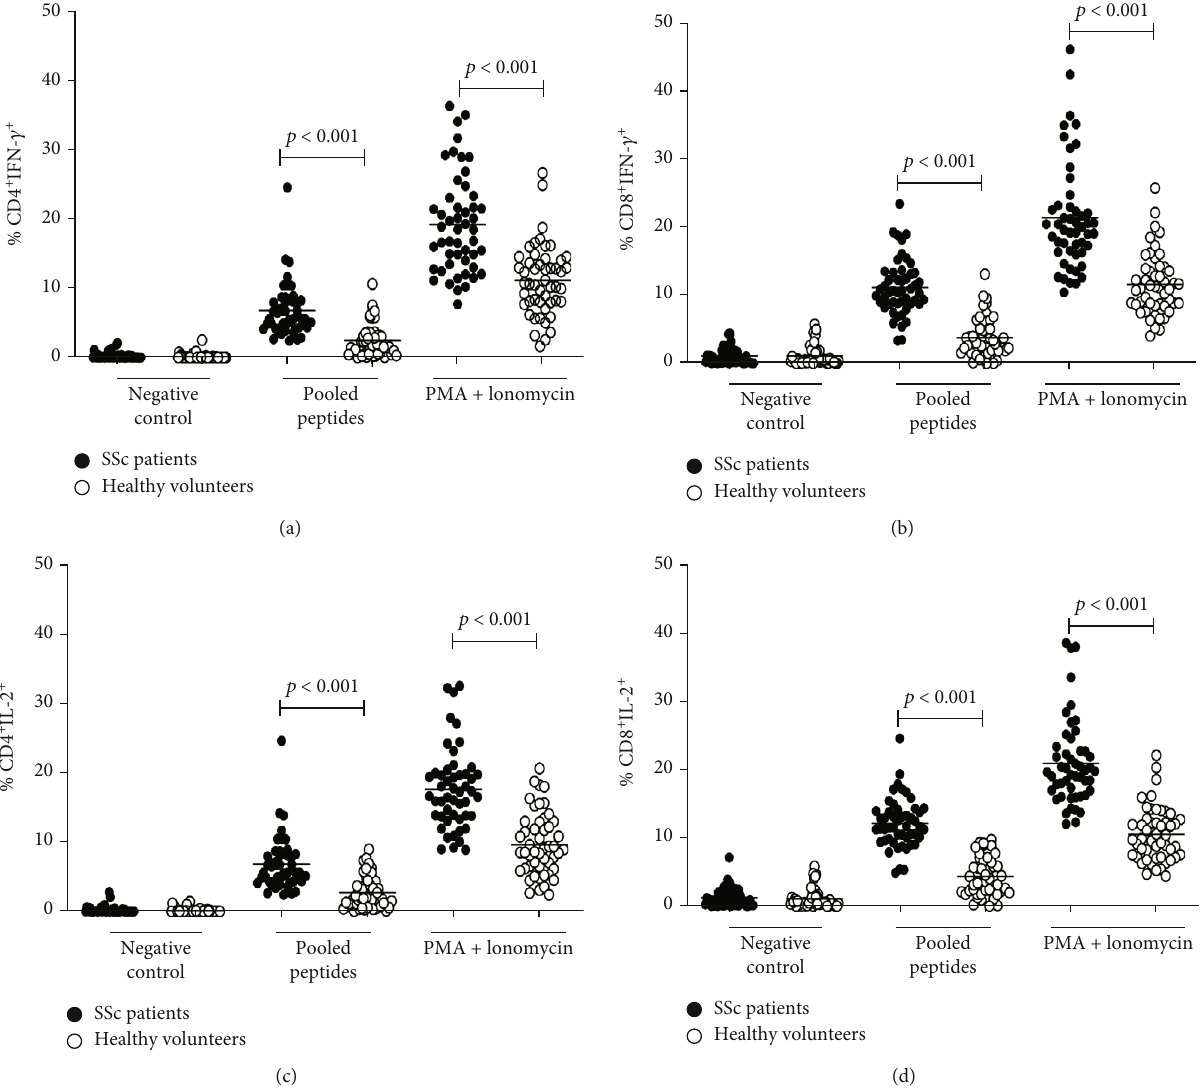
Figure 1: Percentage of cytokines (IFN- γ and IL-2) producing CD4 + (a, c) and CD8 + (b, d) T cells following stimulation with media (negative control), pooled peptides derived from DNA topoisomerase-I protein, and PMA ionomycin (positive control) in SSc patients ( n = 50 ) and healthy volunteers ( n = 50 ) (Student ’ s t -test, p value <